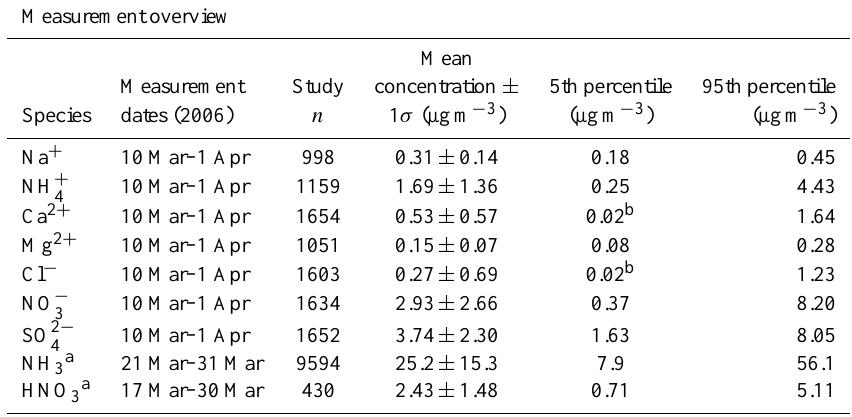
Table 1. Overview of MILAGRO measurements used as modeling inputs. Measurement overview Mean Measurement Study concentration ±